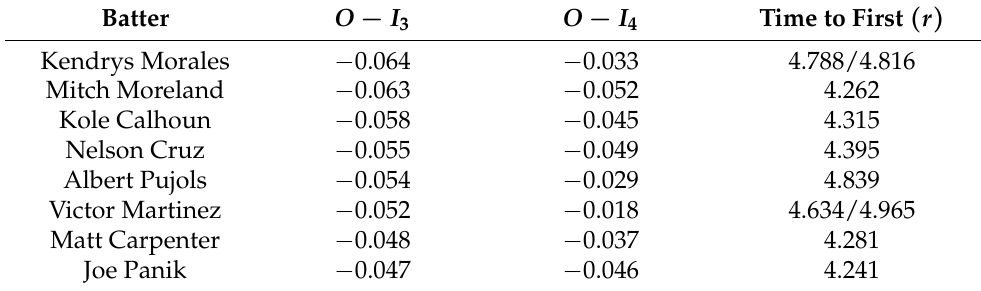
Table 8. Smallest differences between observed weighted on base average (wOBA) on contact ( O ) and wOBA cube values ( O − I 3 ) for 2018; differences between O and wOBA tesseract values ( O − I 4 ) ; and time to first ( r ) in seconds; two r values are given for